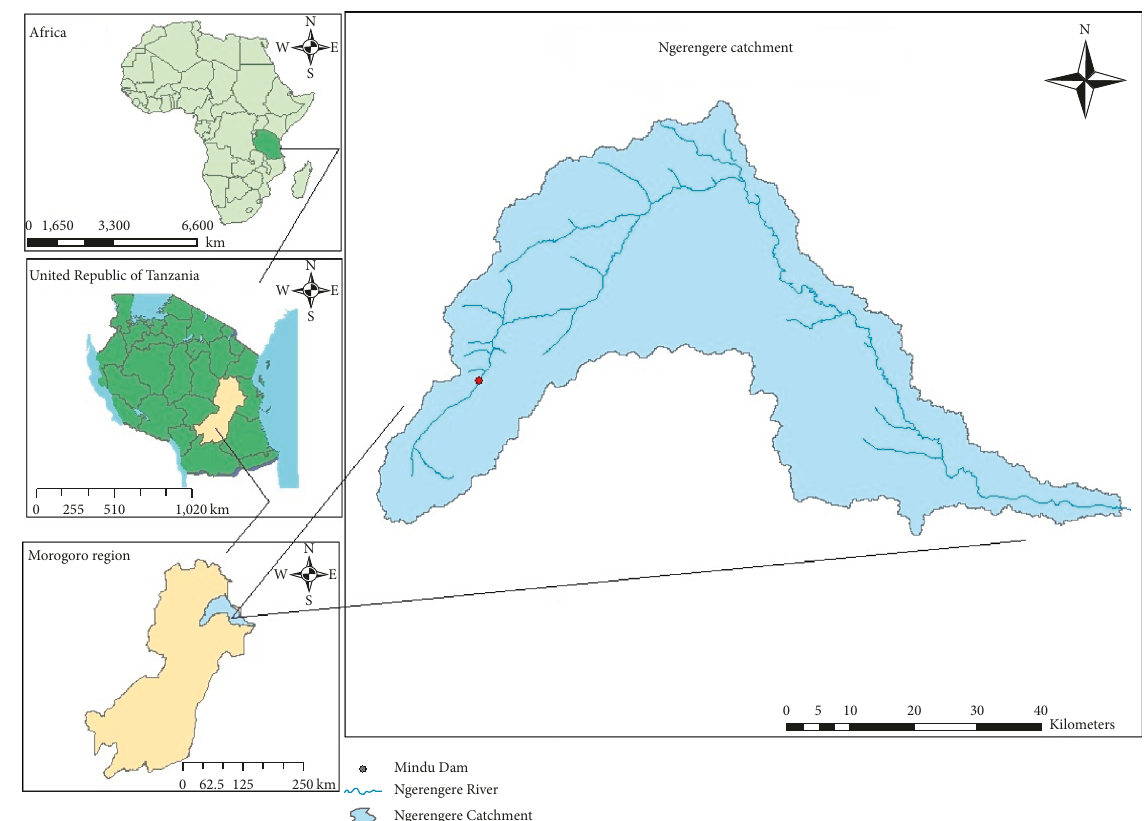
Figure 1: Map of Ngerengere catchment in Morogoro